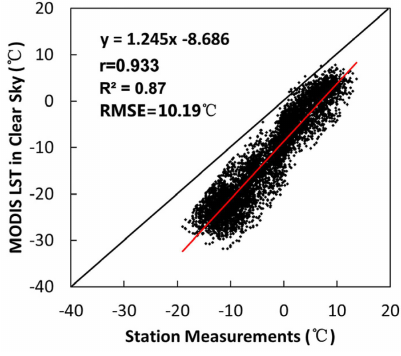
Figure 8. Comparison of station measurements (0–5 cm soil temperatures) with the corresponding MODIS LSTs under clear-sky conditions for the period from 1 August 2010 to 28 July